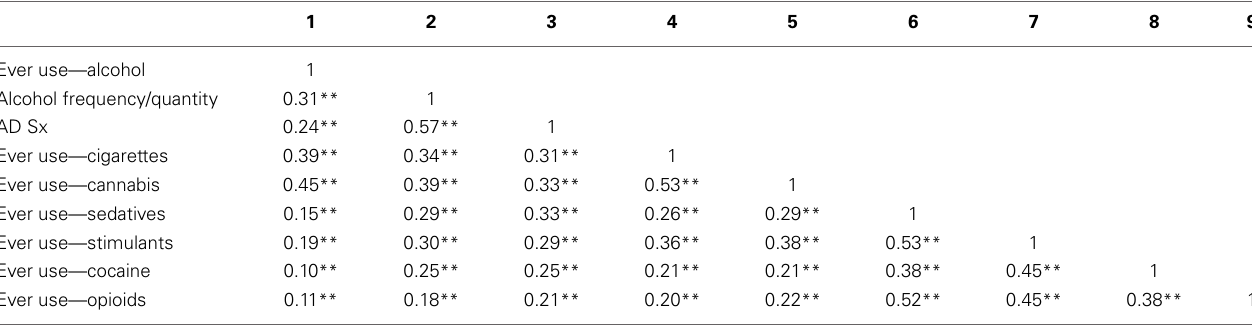
Table 3 | Inter-correlations between substance use variables.